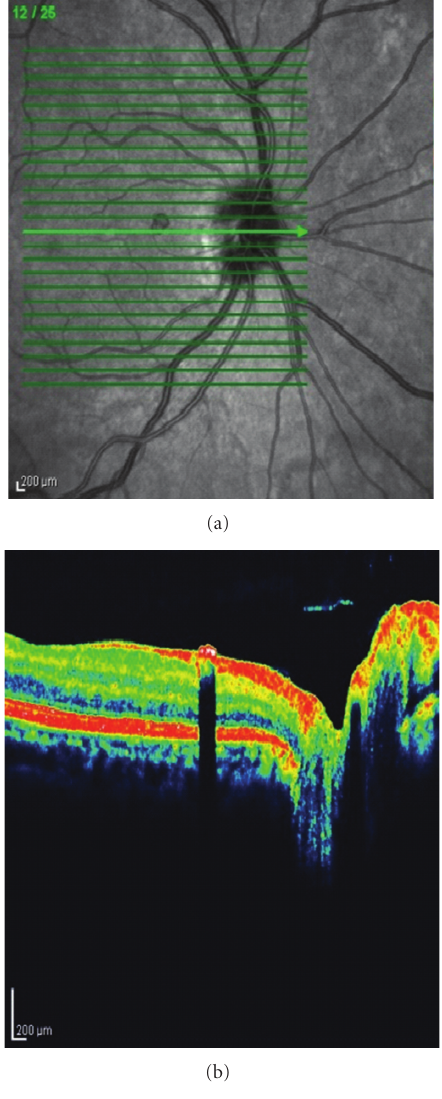
Figure 2: Optical coherence tomography scanning showed an elevated retina at the site of the lesion, increased optical reflectivity on its inner surface, optical shadowing of deeper structures, and clearly cut tumor margins.